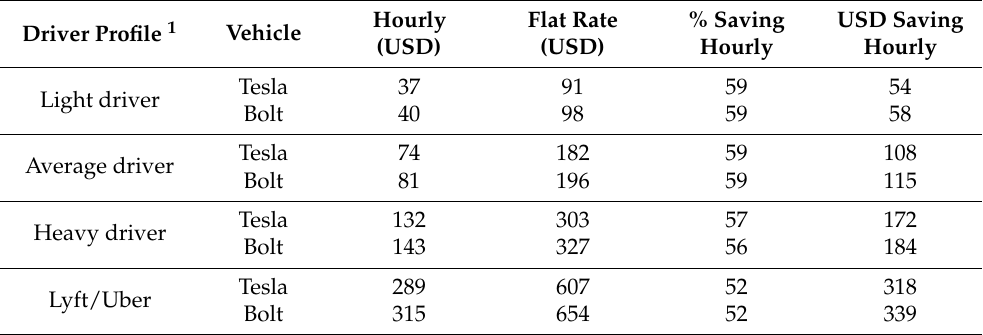
Table 6. Hourly and flat charging rates for Tesla and Bolt and corresponding savings over conven- tional petrol cars